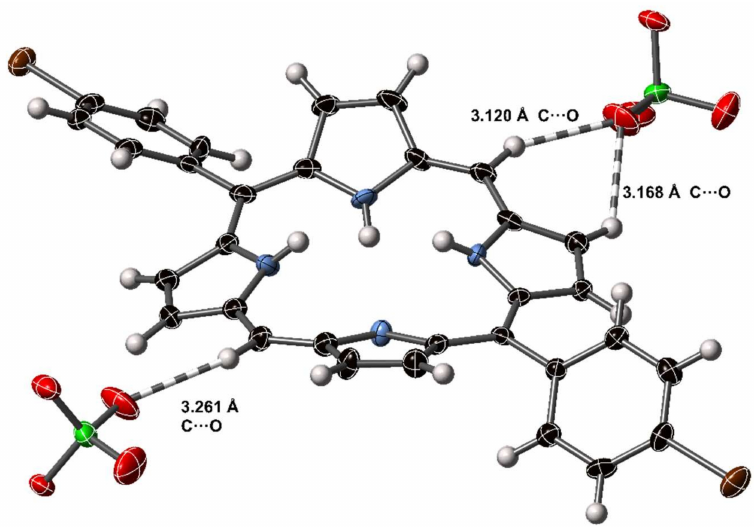
Figure 11. C–H ··· O interactions in the crystal structure of [H 4 18 ][ClO 4 ] 2 . Dashed lines indicate H–O close contact interactions; non-H atoms are represented as thermal ellipsoids at 50% probability, H atoms as spheres of fixed